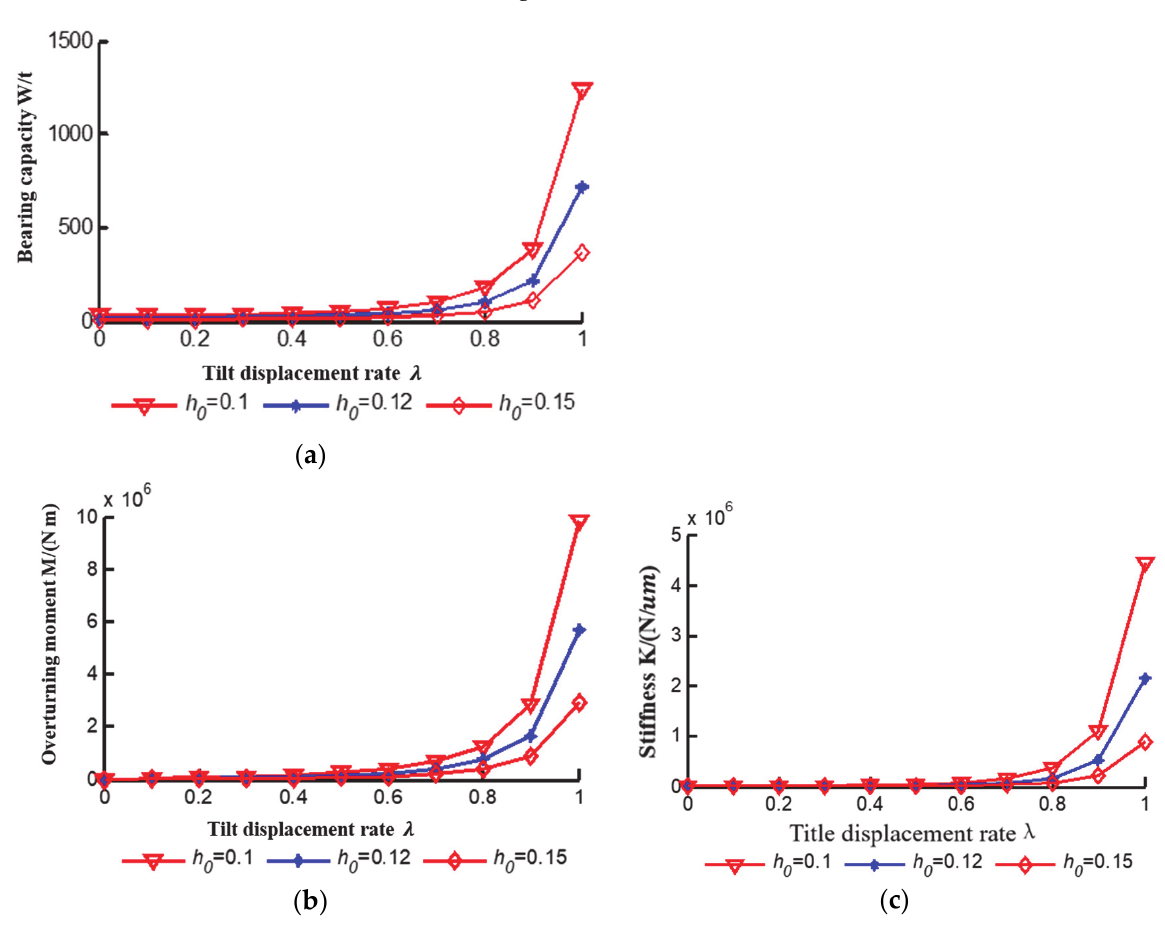
Figure 11. Influence of inclined displacement rate on bearing characteristics. ( a ) Influence on oil film bearing capacity; ( b ) Influence on oil film overturning moment; ( c ) Influence of inclined displacement rate on oil film stiffness.